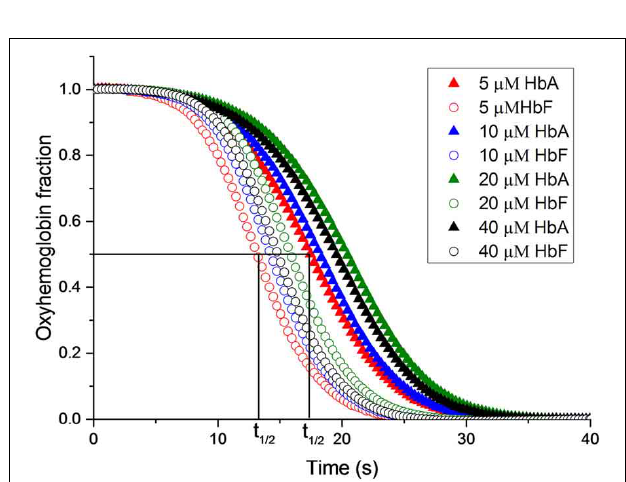
FIGURE 6 | The reaction between oxyhemoglobin and nitrite. Different oxyHb concentrations were incubated with 2mM NaNO 2 . in 20mM sodium phosphate buffer buffer pH 7.4 at 25 ◦ C. The increments of oxyHb levels were monitored at at 577nm. The half-time of the reaction (t 1 / 2 ) is